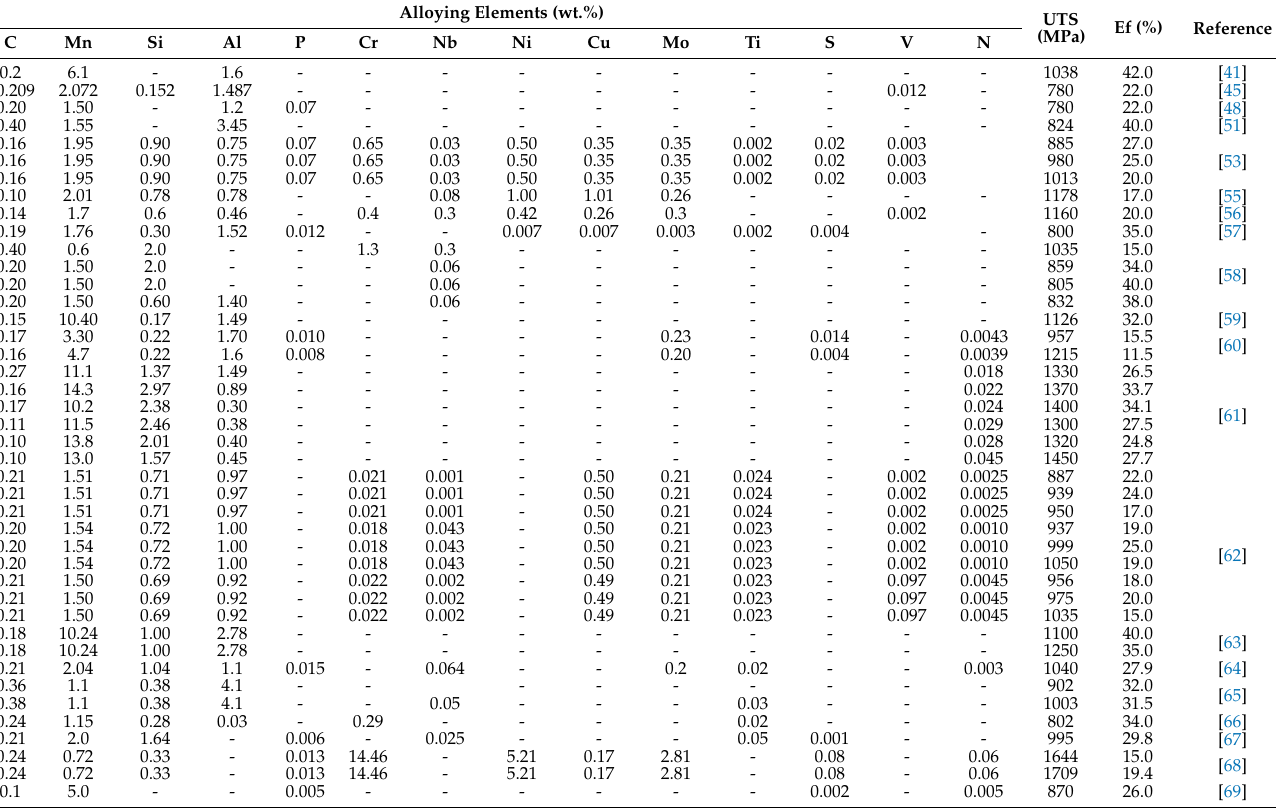
Table 1. Chemical composition and mechanical properties of AHSS to obtain the multiple linear regression model.